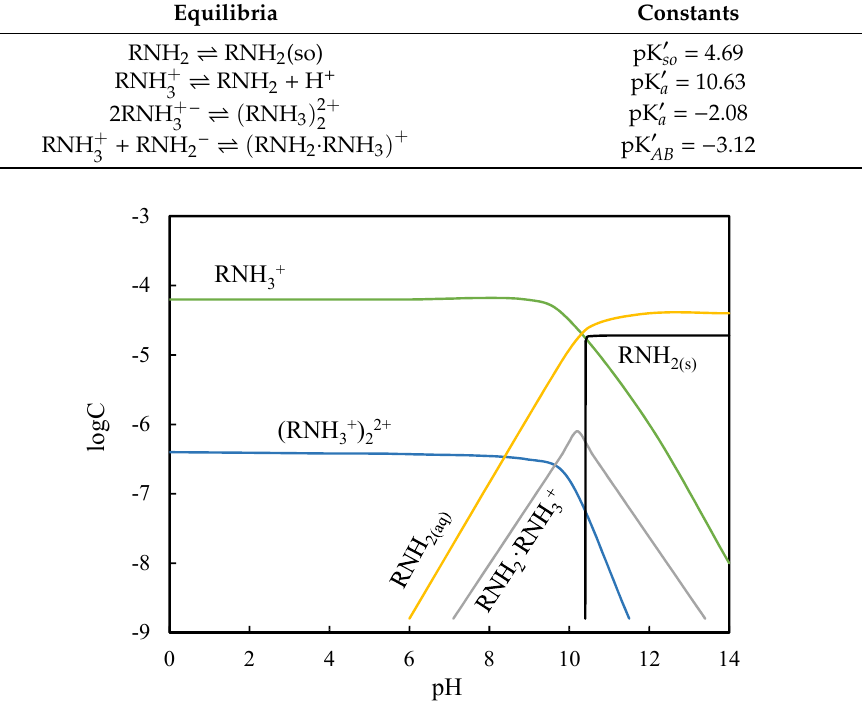
Figure 4. Species distribution diagram of dodecylamine as a function of pH (total concentration = 5 × 10 − 5 mol / L) (after [40]).